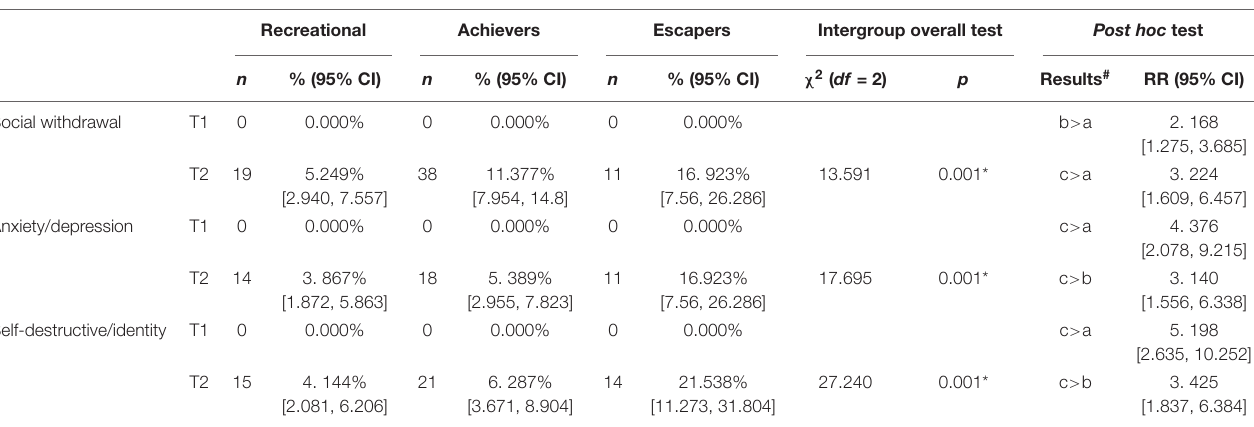
FIGURE 2 | Radar map of characteristics for each cluster. ADV, advancement motive; C, cluster; ESC, escapism motive; REL, relationship motive; RSES, Rosenberg Self-Esteem Scale. Full lines indicate mean Z scores for each cluster, dashed lines denote the mean Z score of the entire sample. TABLE 3 | One-year incidence rates and RRs of negative psychosocial outcomes by